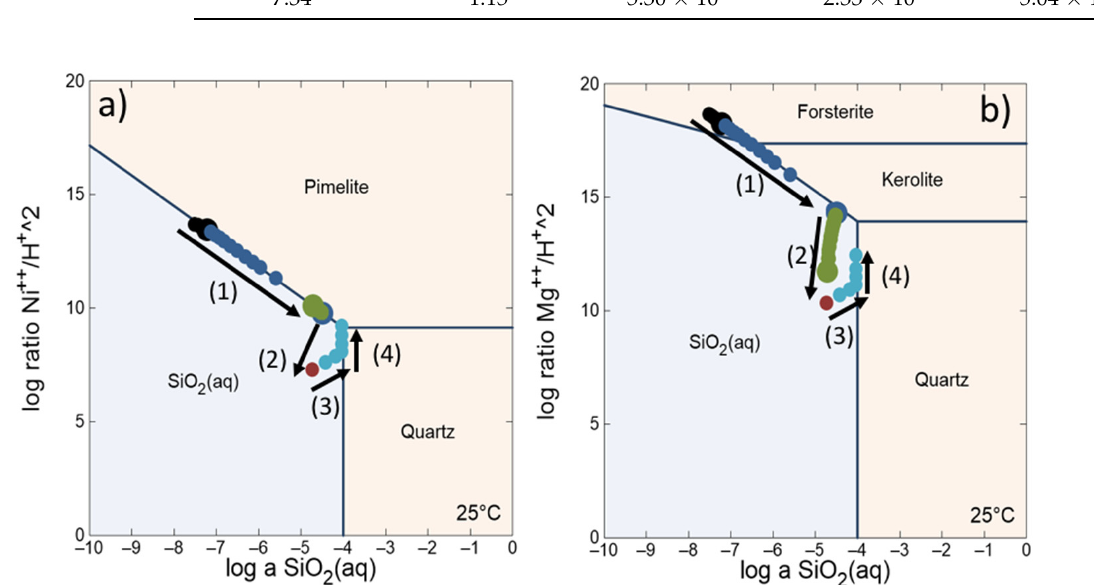
Figure 15. Chemical path of the mineralogical evolution in fractures in activity diagrams. ( a ) the Ni 2+ /(H + ) 2 − SiO 2 and ( b ) Mg 2+ /(H + ) 2 – SiO 2 . In colours, the predominant species in the system: Black: Olivine; Blue: Mg-Kerolite; Green: Pimelite; Red: Goethite; Light Blue: Quartz. (1) Progressive silicate dissolution. (2) Goethite dissolution in the overlaying laterite. (3) Evaporation up to quartz saturation. (4) Evaporation up to pimelite saturation.